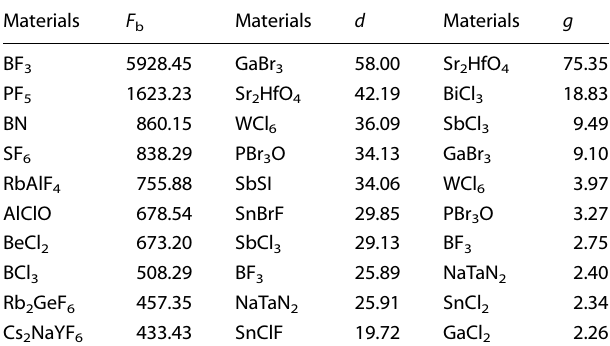
Table 3. Dielectric breakdown and piezoelectric constant of DFT predicted materials. Materials